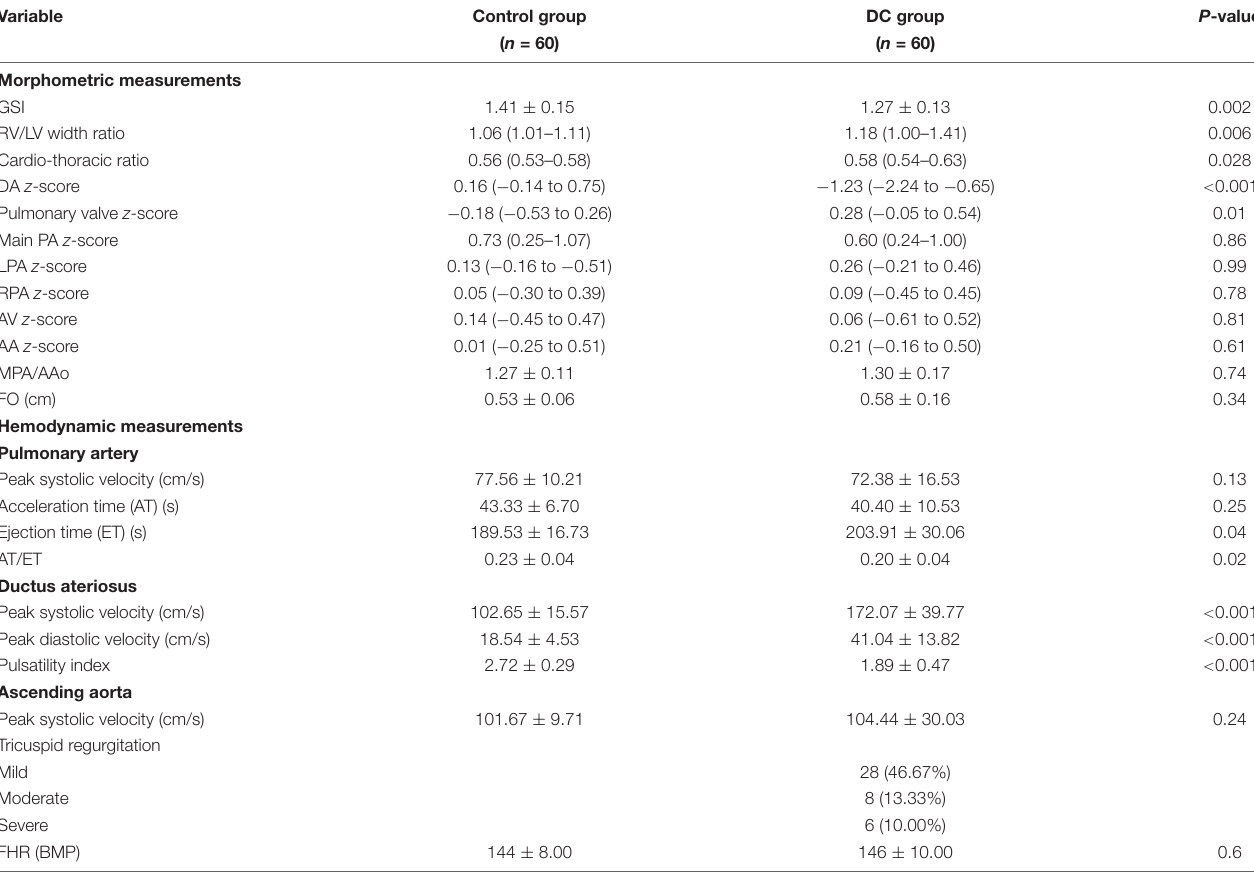
TABLE 2 | Fetal conventional echocardiographic parameters in the study population. Variable